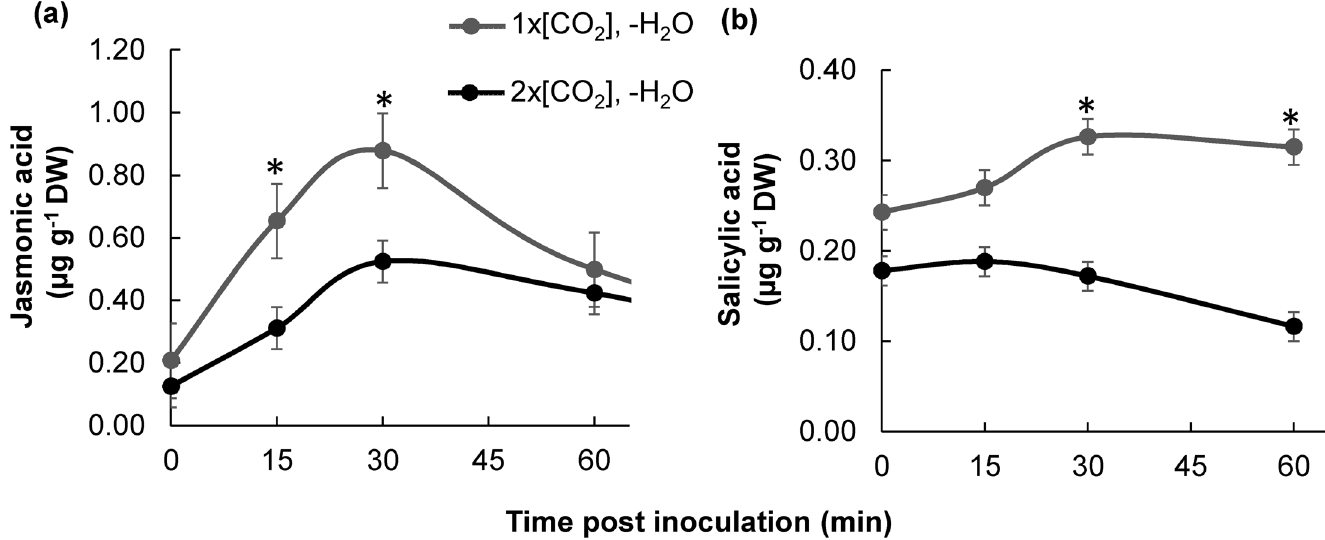
Fig 6. The initial burst of phytohormones following F . verticillioides ( Fv) inoculation was reduced in plants under 2x[CO 2 ] and drought (-H 2 O) conditions. The initial responses of (a) JA and (b) SA was tracked by quantifying phytohormone levels throughout a one hour time course post Fv inoculation of drought treated (-H 2 O) maize stalks at 1x[CO 2 ] or 2x[CO 2 ]. Error bars represent SEM and asterisks indicate significant differences between 1x[CO 2 ] and 2x[CO 2 ] at a particular time point ( t -test, n = 4, P <